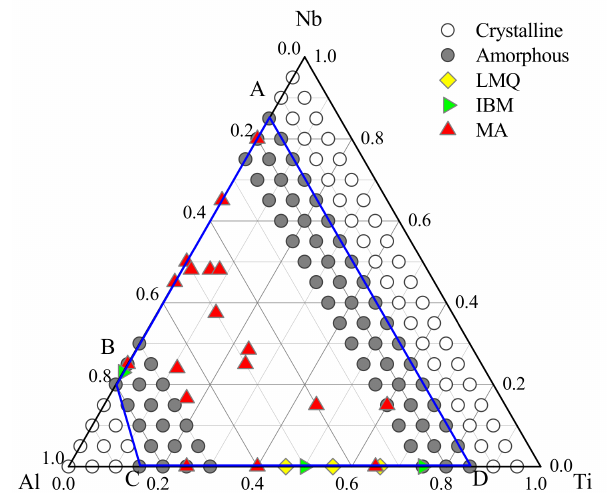
Figure 3. The glass formation range/region (GFR) (inside the quadrilateral) of the Ti-Nb-Al system obtained from Molecular Dynamics (MD) simulations.